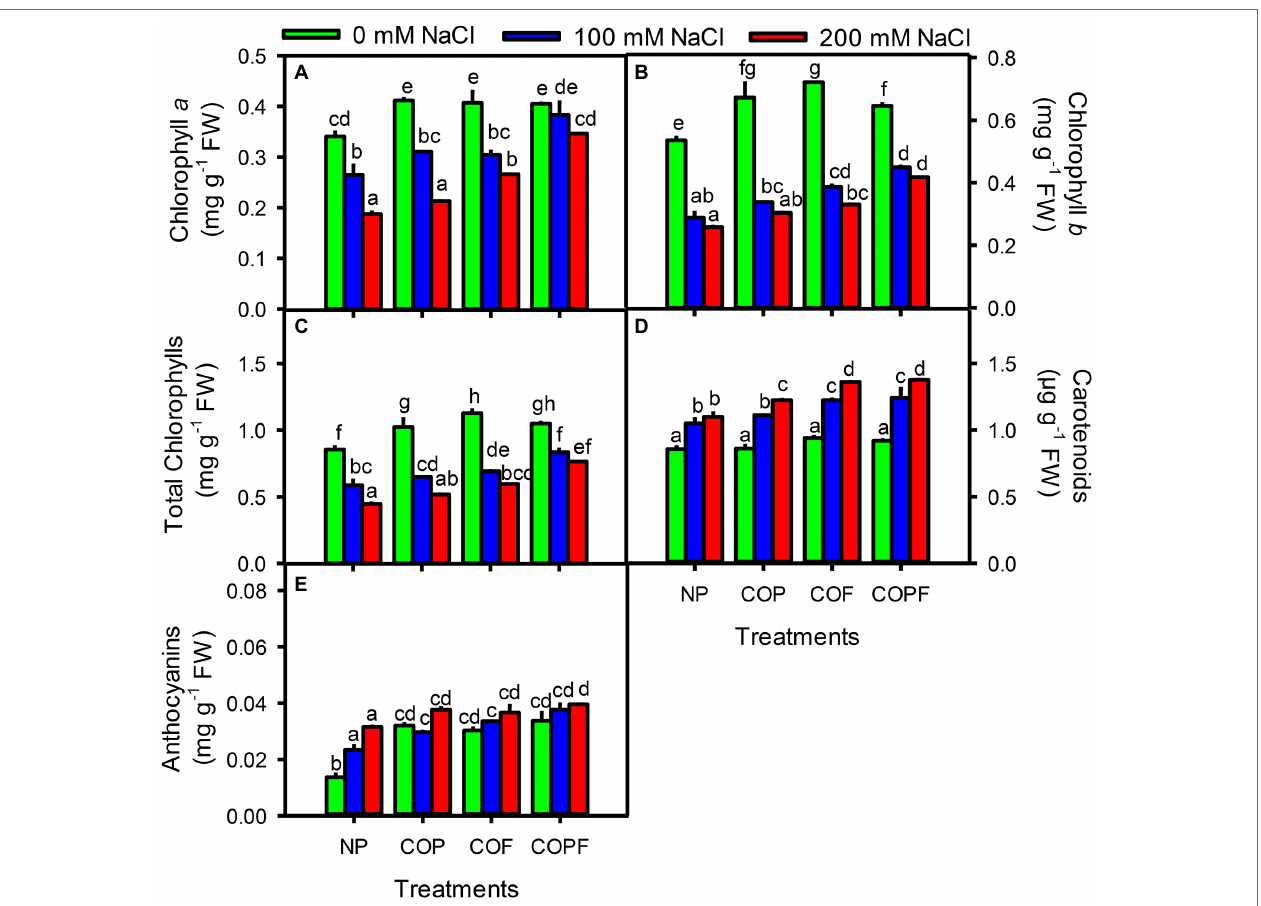
FIGURE 2 | Effect of salinity and coumarin applications on Photosynthetic Pigments. Chlorophyll a (A) , Chlorophyll b (B) , Total chlorophylls (C) , Carotenoids (D) and Anthocyanins (E) . Plants were treated with 0 mg L − 1 coumarin (NP), 100 mg L − 1 coumarin as seed priming (COP), 100 mg L − 1 coumarin as foliar application (COF) and combined treatment (COPF), under 0, 100 and 200 mM NaCl. Values are represented as means ±SE ( n = 3). Different letters represent significant differences ( p < 0.05) by Tukey’s HSD